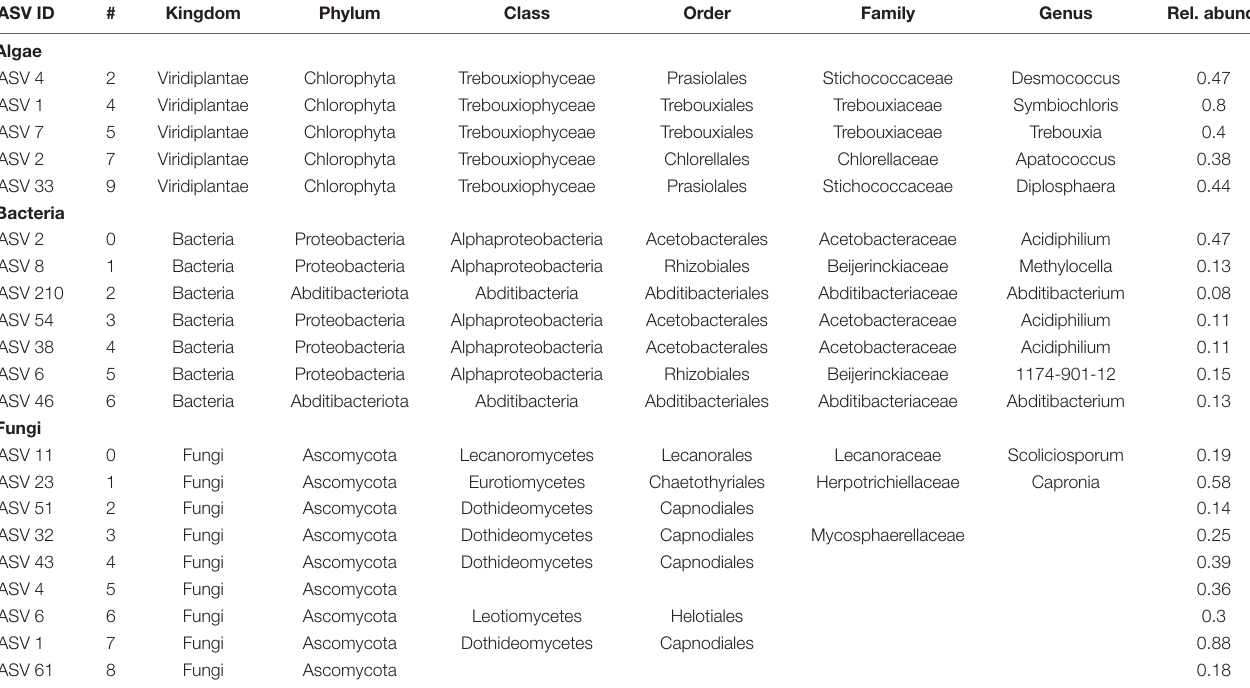
TABLE 3 | Taxonomic assignment of the most abundant ASVs and their relative abundance for modules with more than 10 ASVs.